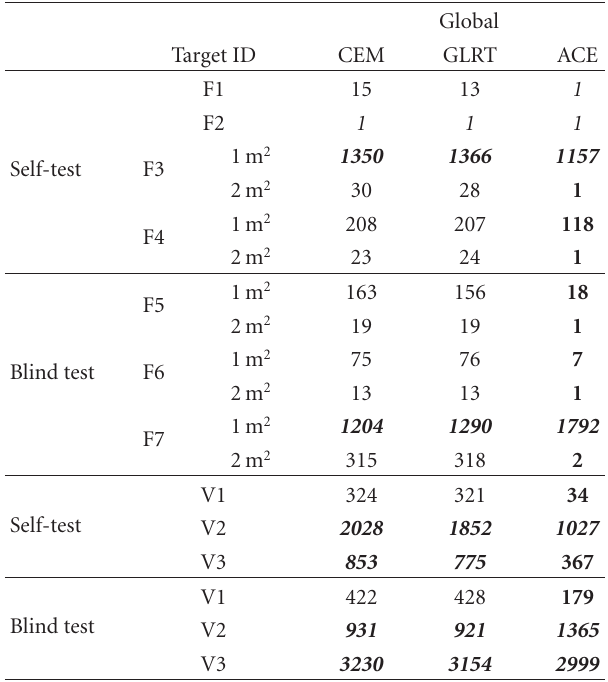
Table 3: Results of local GLRT for di ff erent-sized windows.